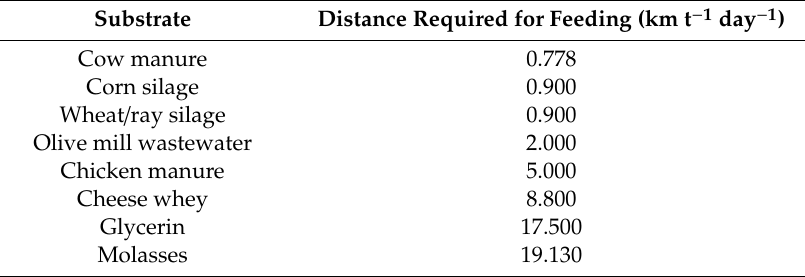
Table 3. Distance required for the feeding of each substrate.